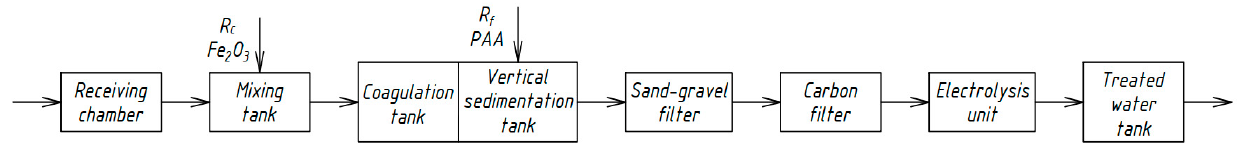
Figure 4. Wastewater treatment scheme with a flotation column .